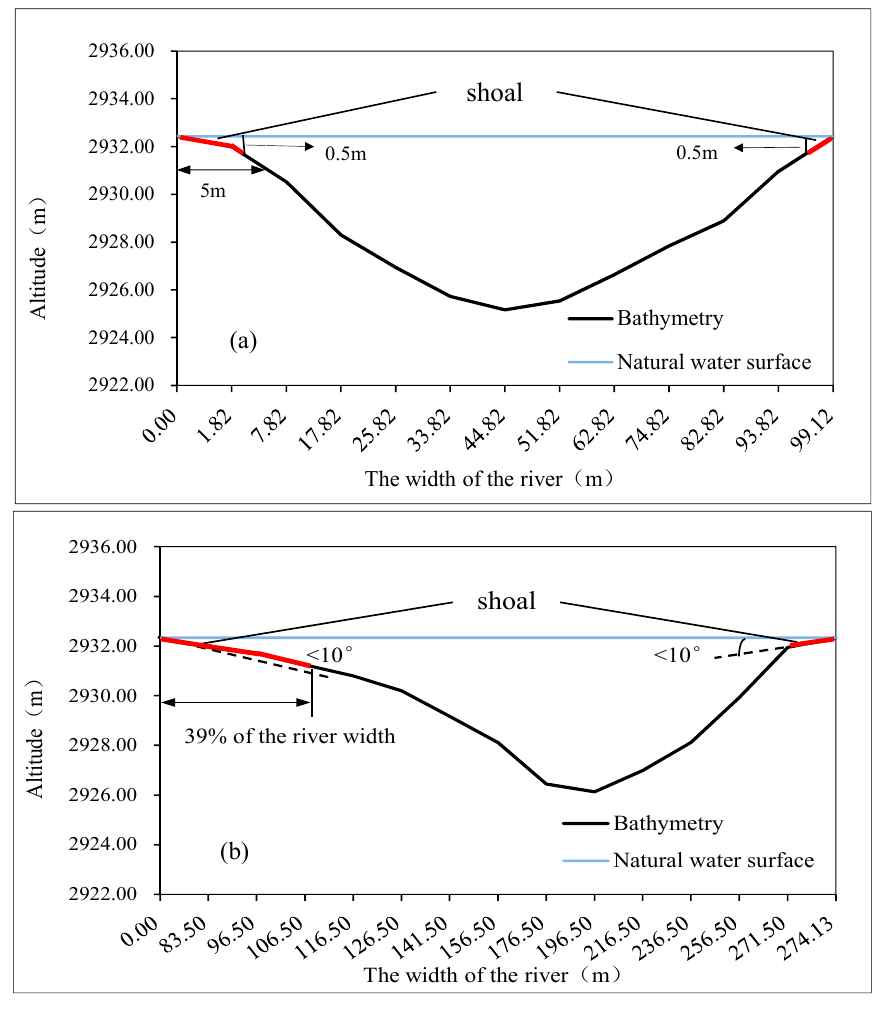
Figure 7. Schematic diagram of shoal boundary when d ≤ 0.5 m within 5 m ( a ) and when α ≤ 10° (b).